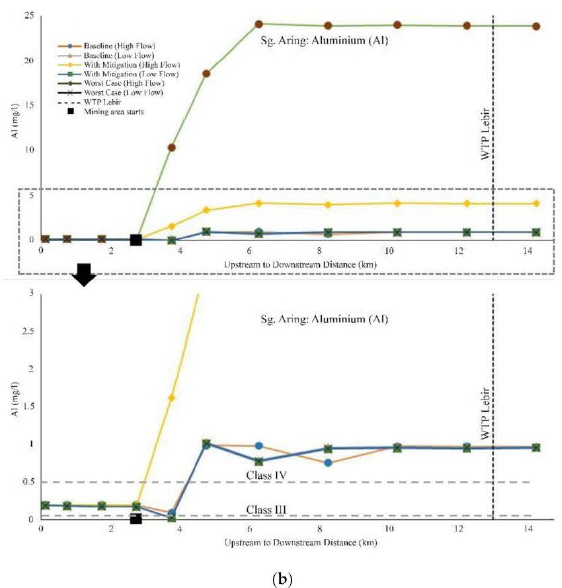
Figure 8. ( a , b ) showing Fe concentration in different scenarios for Sungai Lebir and Sungai Aring, respectively.